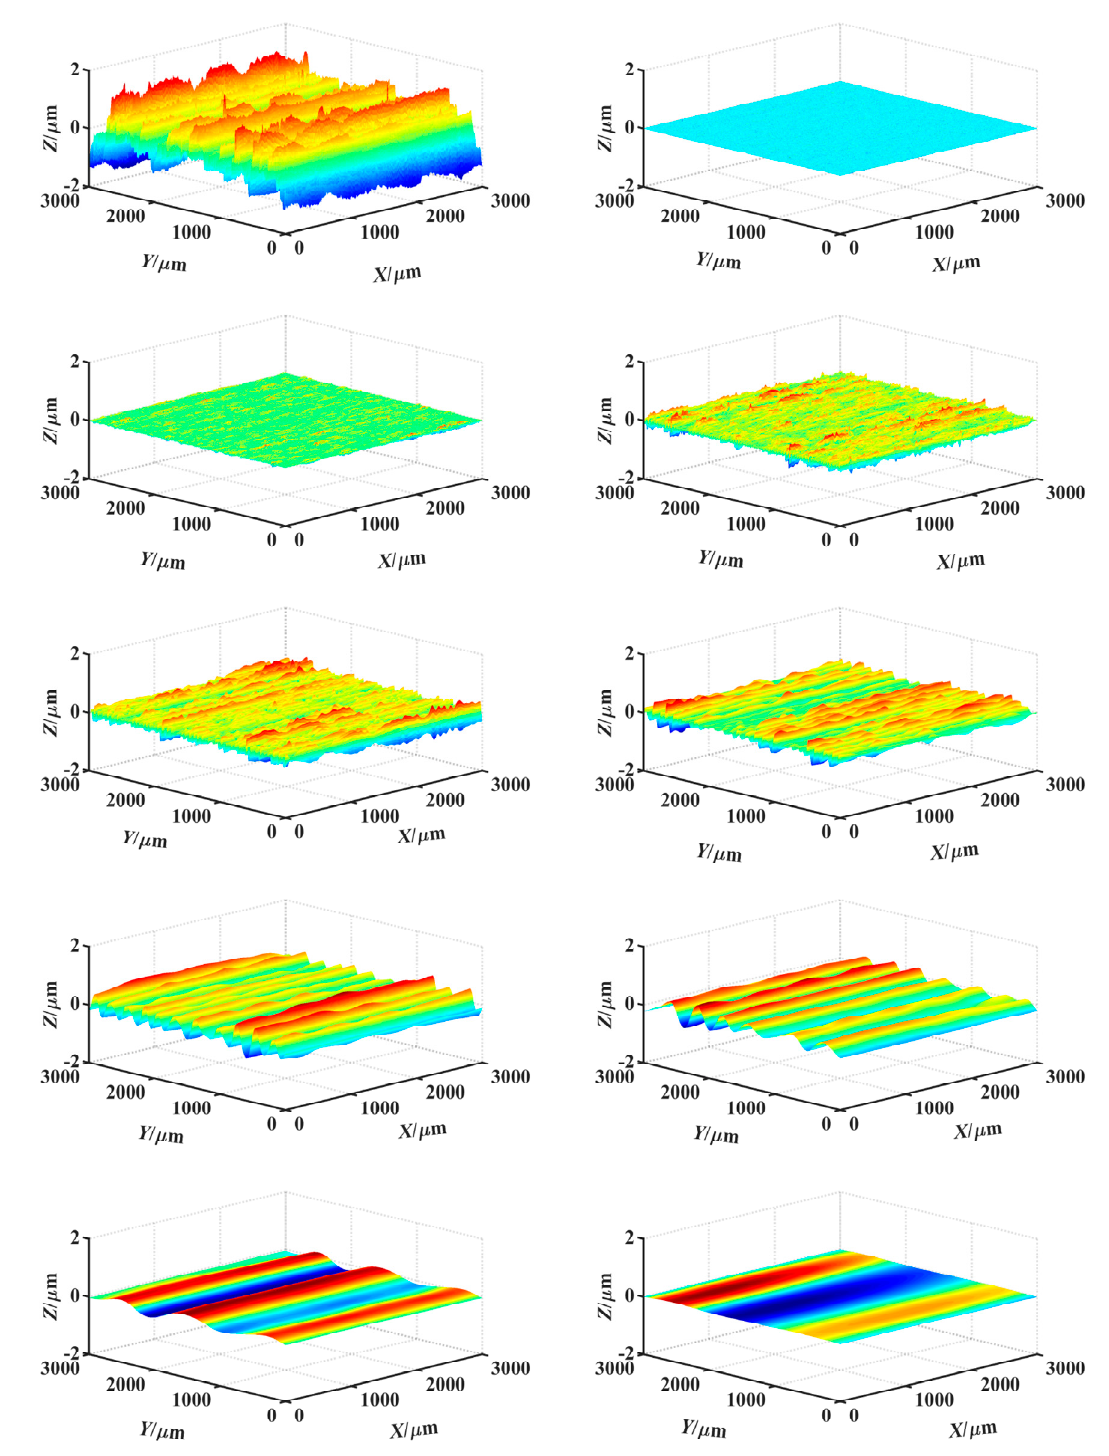
Figure 5. Reconstruction topographies of high-frequency under different decomposition scales. The reconstructed topographies at scales 1, 2, and 3 were integrated together as the HFB component. Meanwhile, the reconstructed topographies at scale 8 and 9 were inte- grated as the LFB component. The reconstructed topographies of the HFB and the LFB constituted the digital combination model, as shown in Figure 6.